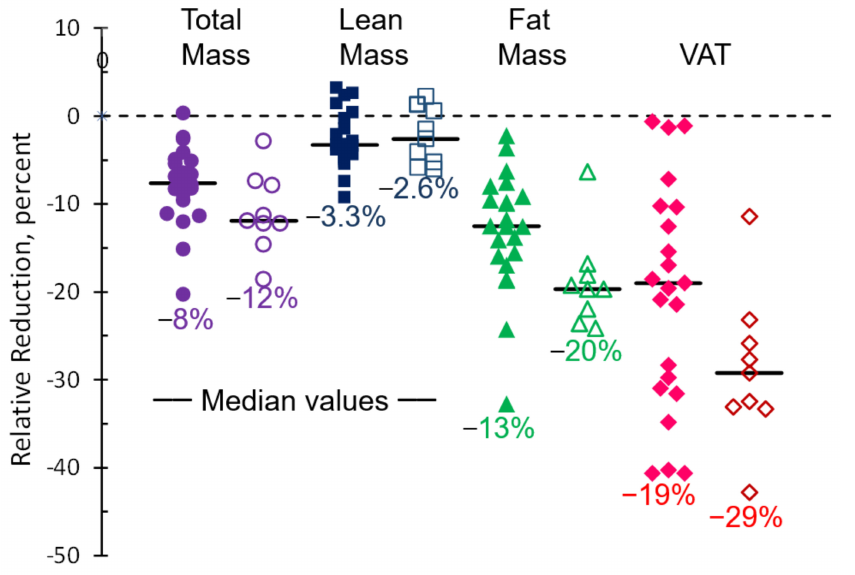
Figure 2. Change in body composition after 12 weeks (closed symbols) for 22 participants in cohorts 1 and 2; and 24 weeks (open symbols) for 9 participants in cohort